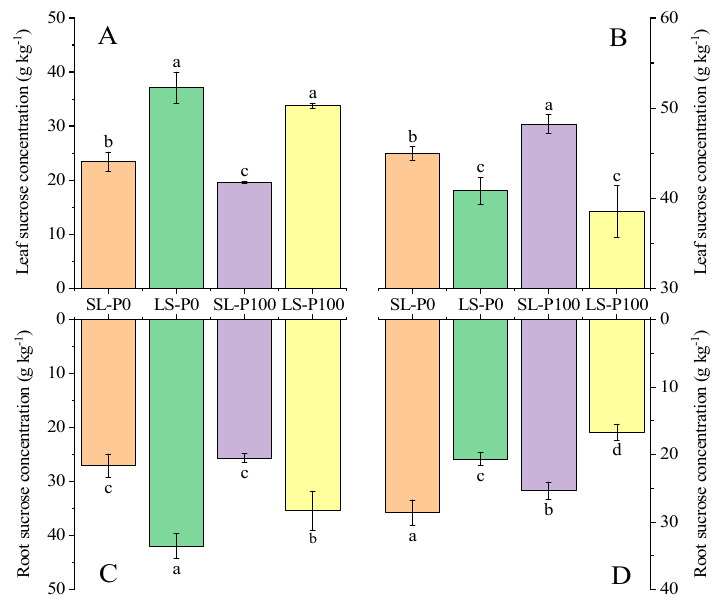
Figure 6. The effect of P application and light condition on the leaf sucrose concentration (( A ): V5 stage, ( B ): R3 stage), root sucrose concentration (( C ): V5 stage, ( D ): R3 stage) in the field experiment. Plants were grown in two light conditions (SL: shade from sowing to the V5 stage and from V5 to R8 under natural light condition; LS: from sowing to the V5 stage under natural light condition and shade from V5 to R8) and two P application treatments (P0 = without P application; P100 = 100 mg P kg − 1 soil application). Values represent the mean of three replicates ± SE. Different letters on the columns are used to indicate means that differ significantly by LSD ( p ≤ 0.05).